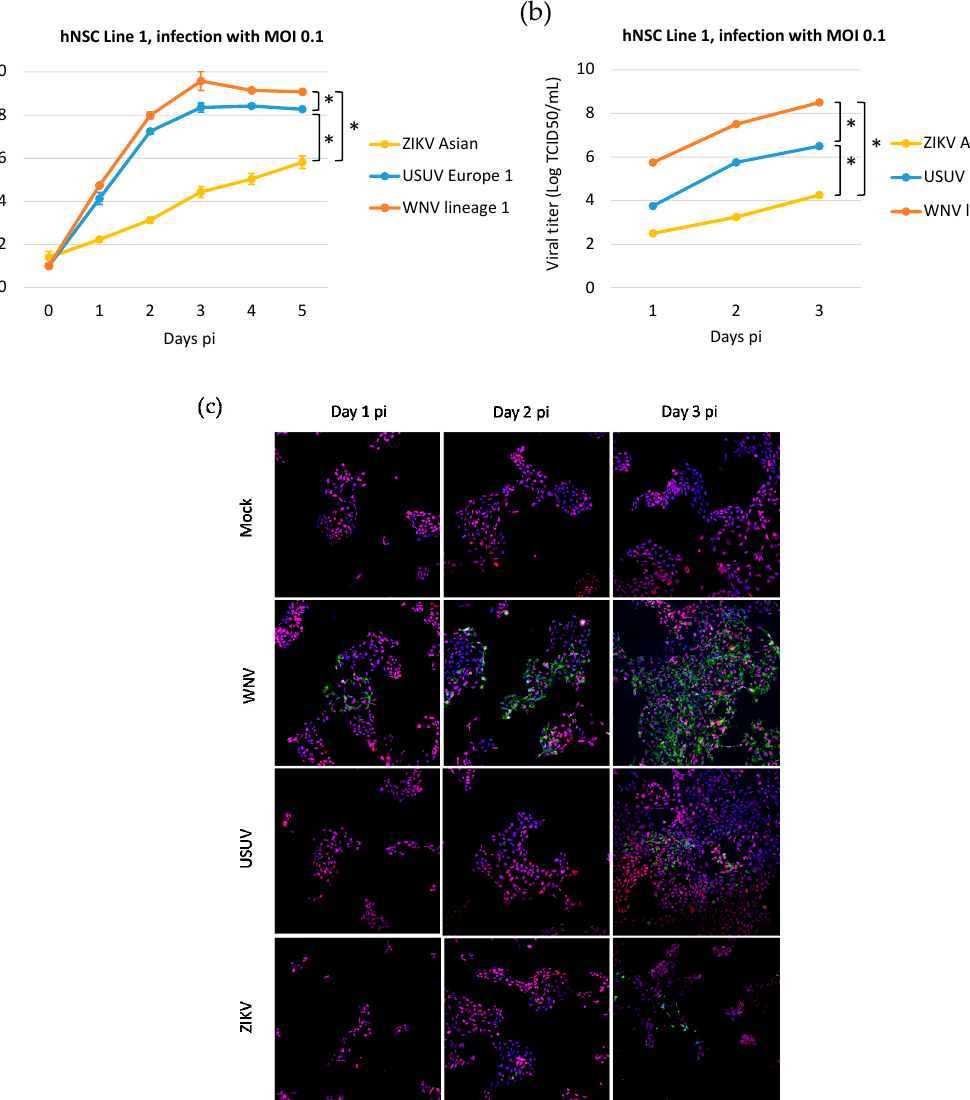
Figure 7. WNV, USUV and ZIKV production kinetics on hiPSC-derived human neural stem cell (hNSC) line 1. ( a ) Cells were infected with WNV lineage 1, USUV Europe 1 and ZIKV Asian at MOI 0.1 and viral RNA load was measured in cell culture supernatant by qRT-PCR daily, from day 0 to day 5 p.i.; results are reported as Log viral RNA copies / mL. Analyses were performed in triplicate and repeated in two independent experiments. ( b ) Viral titer in supernatant of NSCs infected with viruses at MOI 0.1 was measured by TCID50 assay on Vero cells on days 1, 2 and 3 p.i.; results are reported as Log TCID50 / mL. Analyses were performed in triplicate and repeated in two independent experiments. Data represent mean values ± SD of all experiments. * WNV vs. USUV and vs. ZIKV, p < 0.05 by Student’s t -test. ( c ) Representative confocal microscopy images of hNSC line 1 at di ff erent days p.i. with WNV lineage 1, USUV Europe 1 and ZIKV Asian lineage at MOI 0.1 or mock infection. Cells were immunolabeled with a pan-flavivirus antibody targeting flavivirus E glycoprotein (green) and with an antibody targeting the NSC marker Pax-6 (red); nuclei were stained with DRAQ5 fluorescent probe solution (blue). Merged images are shown at 20 × magnification .